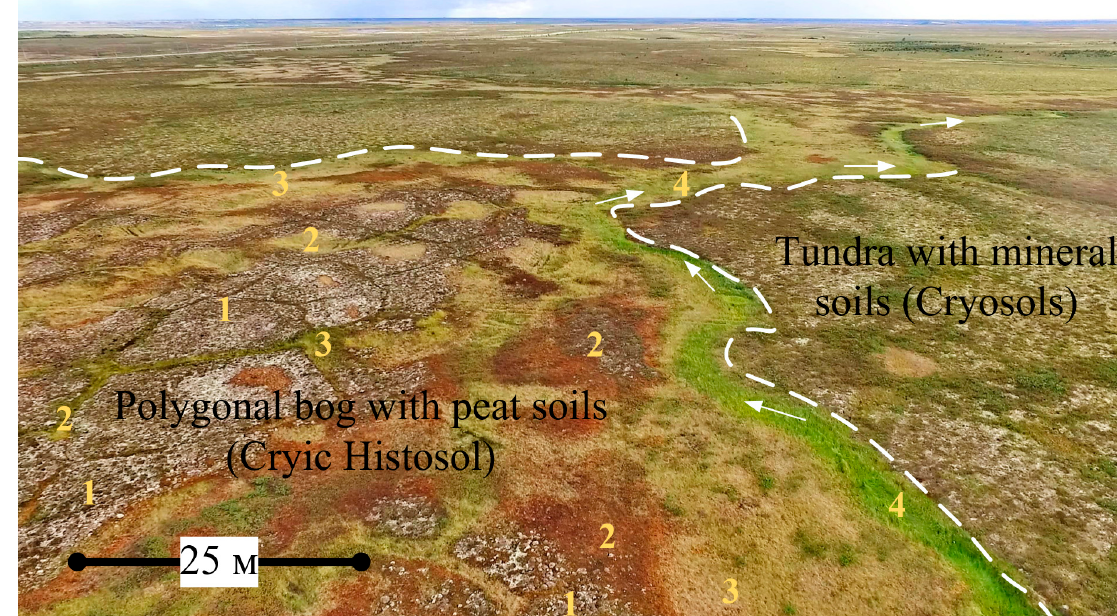
Figure B1. Polygonal bog with microtopes of different hydrological regime at the KS Tazovsky: 1—polygons occupying elevated dry positions; 2—degraded and flooded polygons and small cracks between polygons; 3—large cracks and fens without a watercourse; 4—lower parts of the fens with watercourse. White arrows show the direction of water flow. A white broken line marks the border of a polygonal bog.